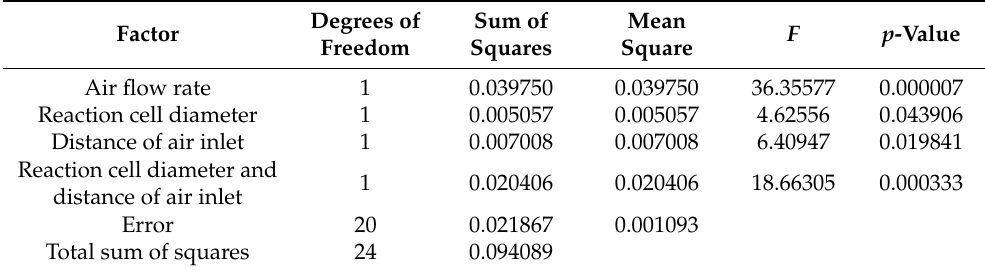
Table 11. Results of the analysis of variance applied to the air velocity in the reaction cell with upper air inlet and outlet geometry. Degrees Factor